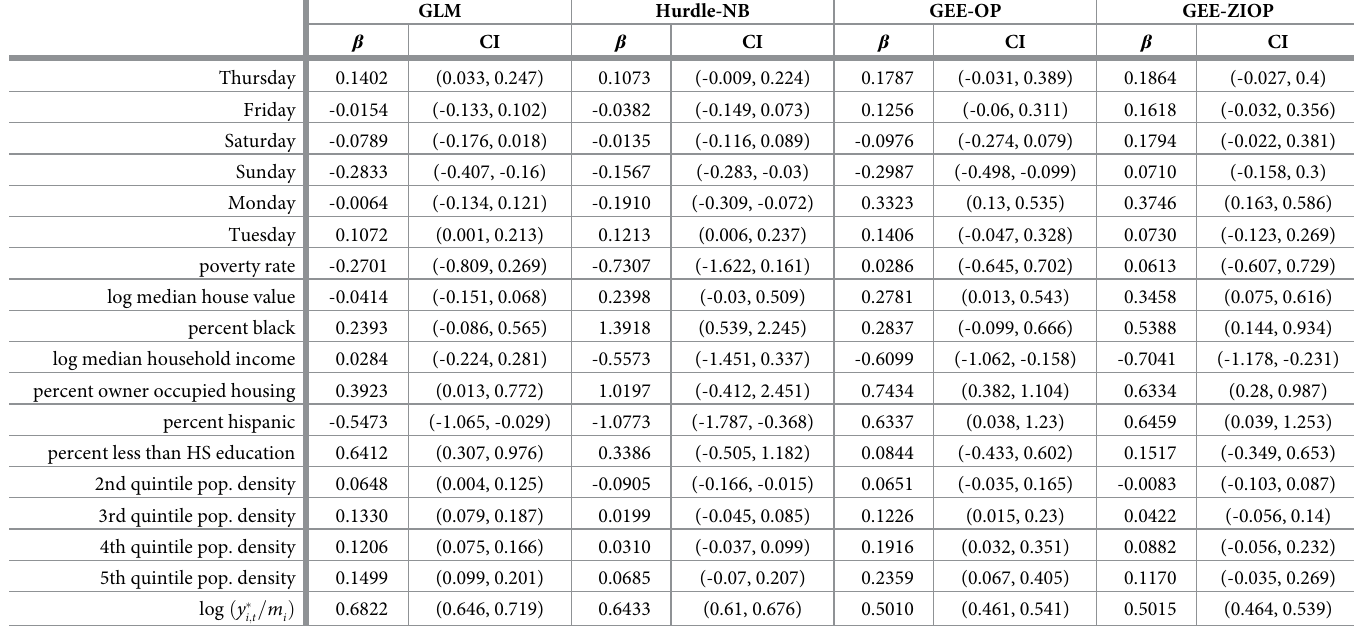
Table 5. Day of week and county demographic coefficients and 95% confidence intervals based on robust standard